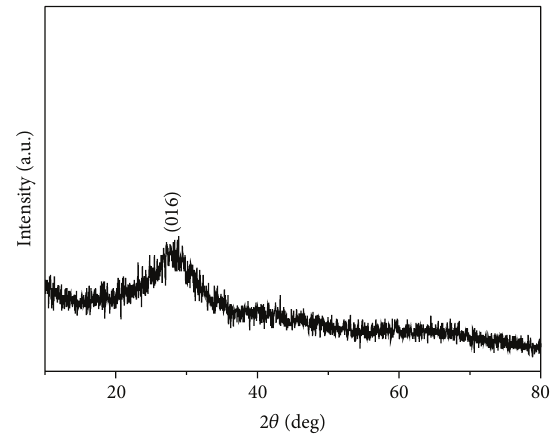
Figure 7: XRD pattern of the ( Bi , Sb ) 2−𝑥 Te 3+𝑥 -based nanowire.